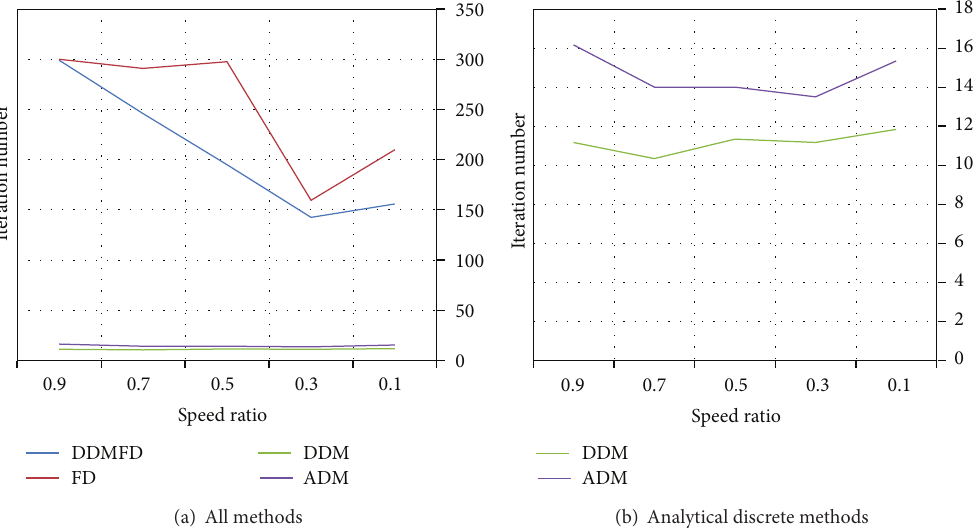
Figure 9: Comparison of iteration number between different sensitivity methods.